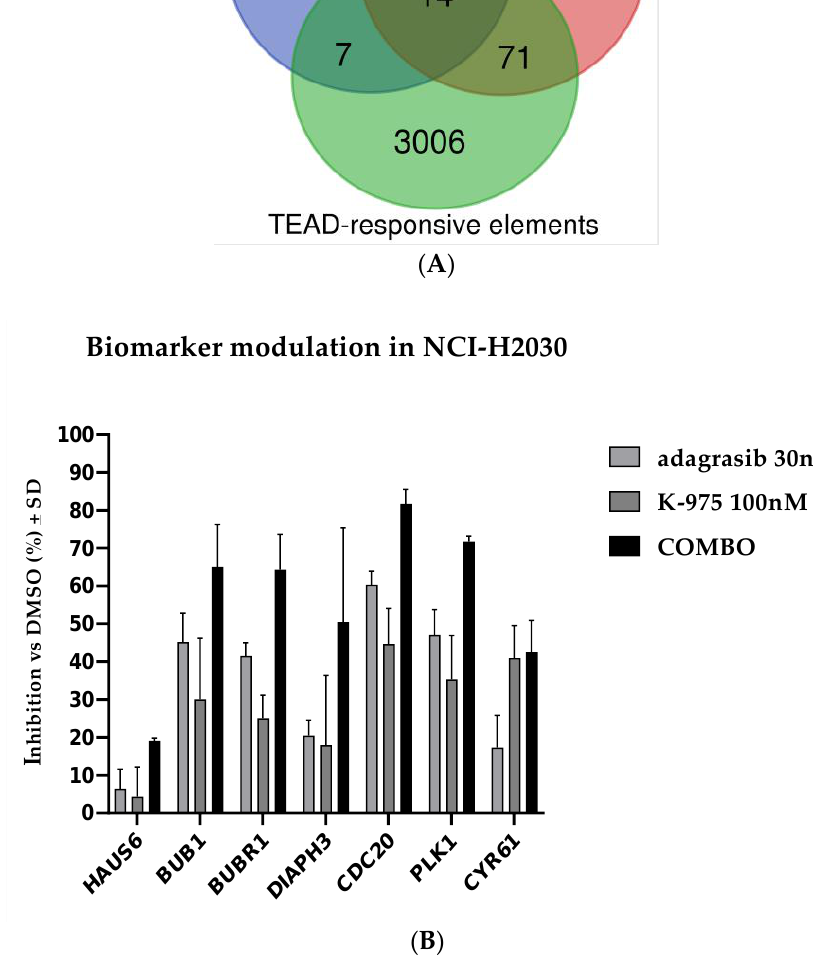
Figure 4. Gene selectively regulated in combination treatment with adagrasib and K-975. ( A ) Venn Diagram between RNA-Seq data, Proteomic data, and TEAD-Responsive elements from ChIP-Seq data. ( B ) Biomarker modulation at 24 h. Percent inhibition of proteins modulated in the conditions tested: DMSO, adagrasib at 30 nM, K-975 at 100 nM, and combination (COMBO; adagrasib and K-975). The data set is on three biological replicates.